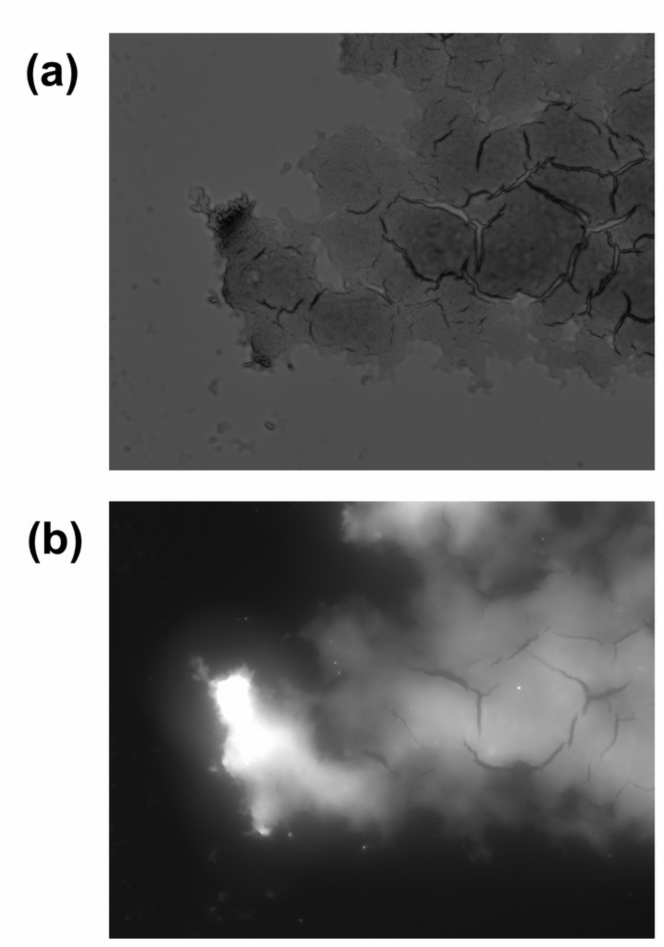
Figure 9. The study of conjugate using a fluorescent microscope: ( a ) light channel; ( b ) channel with quinacrine fluorescence